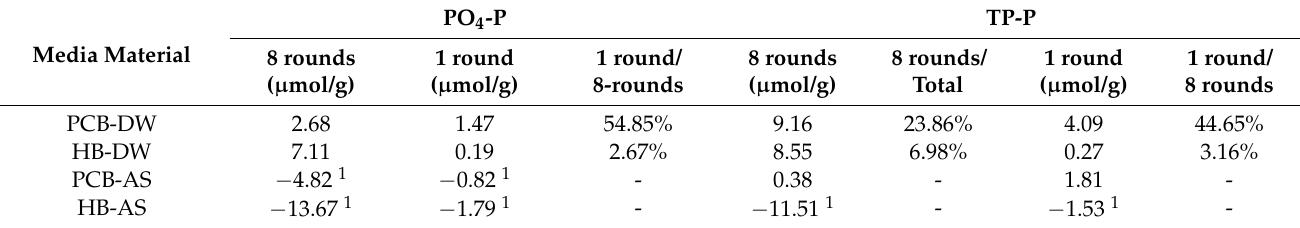
Table 2. Phosphorus leaching quantities of PCB and HB in deionized water (DW) or artificial stormwater (AS).